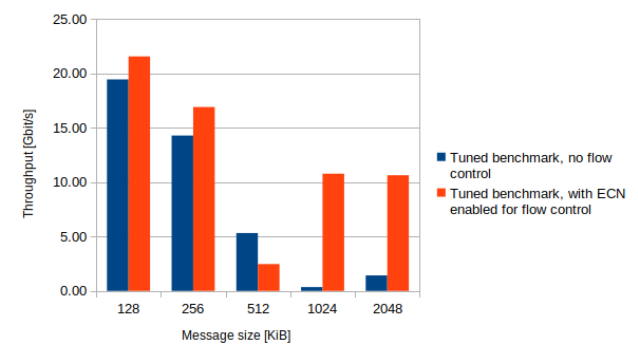
Figure 6. Performance improvement for the the data consumers for the benchmark generating 100-to- 25 Gbit / s tra ffi c and Juniper QFX5200